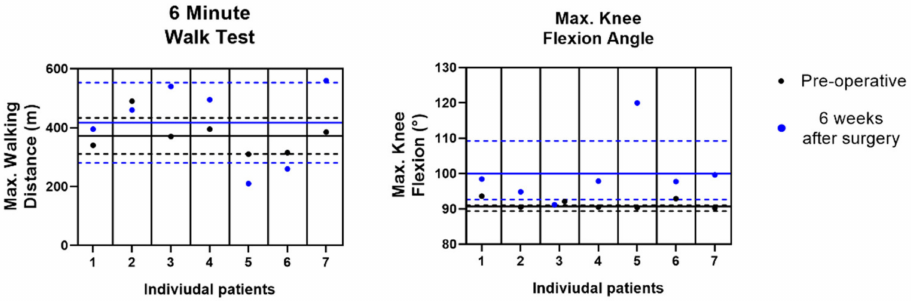
Figure 6. The distance walked over the 6 Minute Walk Test and Maximum Knee Flexion Angle (measured with IMU sensors) pre-operatively and at Post-Op Week 6. The mean (solid line) ± S.D. (dotted line) all individual patient data are